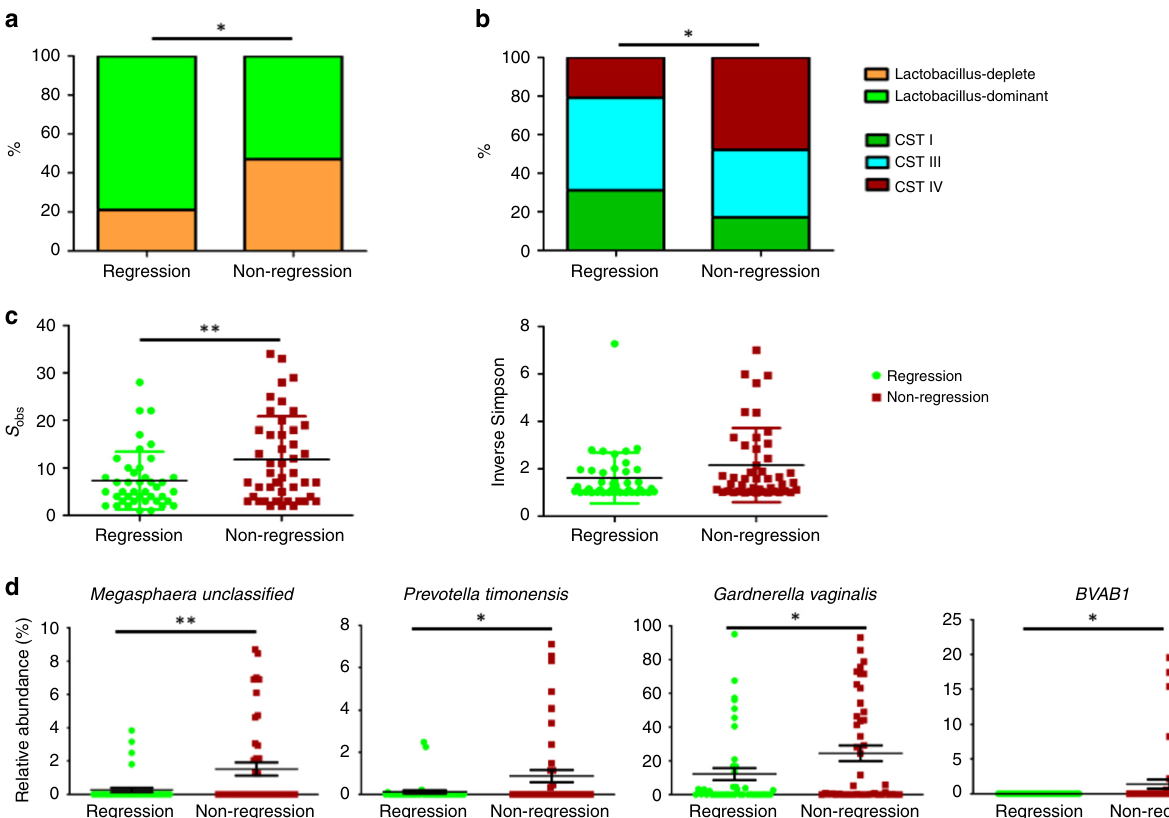
Fig. 4 Outcomes at 12-month follow-up according to baseline VMB composition at baseline. A Lactobacillus spp.-depleted VMB ( a ) and CST IV ( b ) were associated with signi fi cantly lower rates of regression compared to non-regression at 12 months. Signi fi cantly higher species richness (species observed) was seen in women who had not regressed at 12 months follow-up ( p = 0.0091), with diversity (Inverse Simpson index) also increased but this was not signi fi cant ( c ). The baseline vaginal microbiota of women who did not regress at 12 months was characterised by an increased abundance of Megasphaera (unclassi fi ed) ( p = 0.0038, q = 0.081), Prevotella timonensis ( p = 0.015, q = 0.153), Gardnerella vaginalis ( p = 0.036, q = 0.252) and BVAB1 ( p = 0.043, q = 0.228) ( d ). Data are represented as percentages in a , b and c as mean ± standard error of mean in d . The p -values by two-tailed unpaired t -test in c , and by Welch ’ s t -test in d . Dots in c and d depict individual patients. ( n = 87, *** p < 0.001; ** p < 0.01; * p < 0.05). Source data are supplied as a Source Data